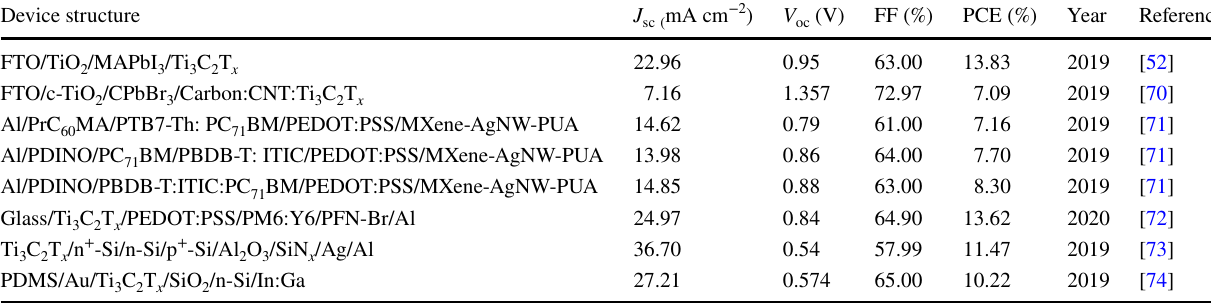
Table 3 Summary of the key parameters for the solar cells employing MXenes as electrodes Device